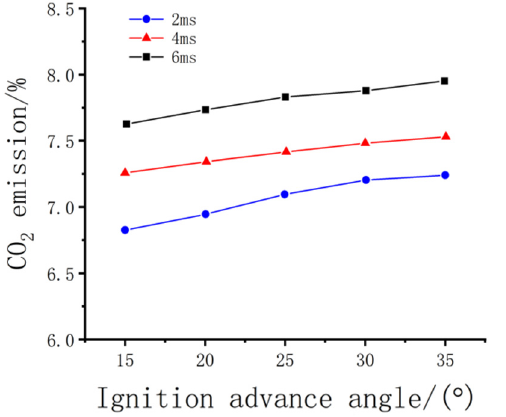
Figure 30. Effect of the ignition parameters on CO 2 emissions.